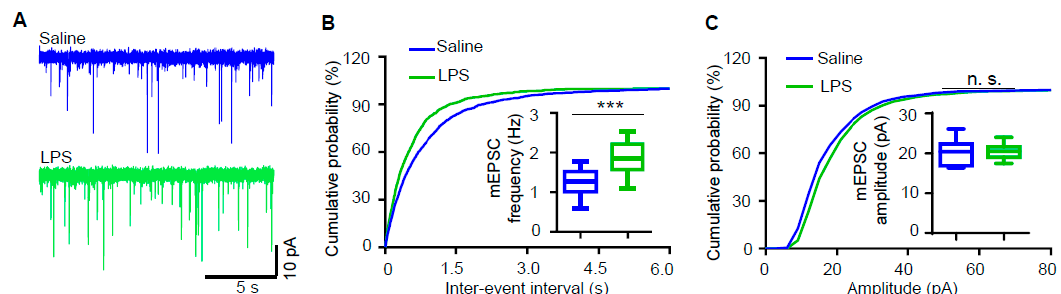
Figure 2. Miniature excitatory postsynaptic current (mEPSC) frequency of hippocampal pyramidal neurons is increased in the LPS-induced depression mouse model. ( A ) Representative traces of mEPSCs in CA1 pyramidal neurons from saline-treated (upper panel, blue) or LPS-treated (lower panel, green) mice. ( B , C ) Cumulative probability plots of mEPSC interevent intervals and histograms of mEPSC frequency ( B ) and amplitude ( C ) (n = 14 neurons from 3 saline-treated mice, n = 16 neurons from 3 LPS-treated mice; Student’s t -test, *** p < 0.001, n.s. p > 0.05).